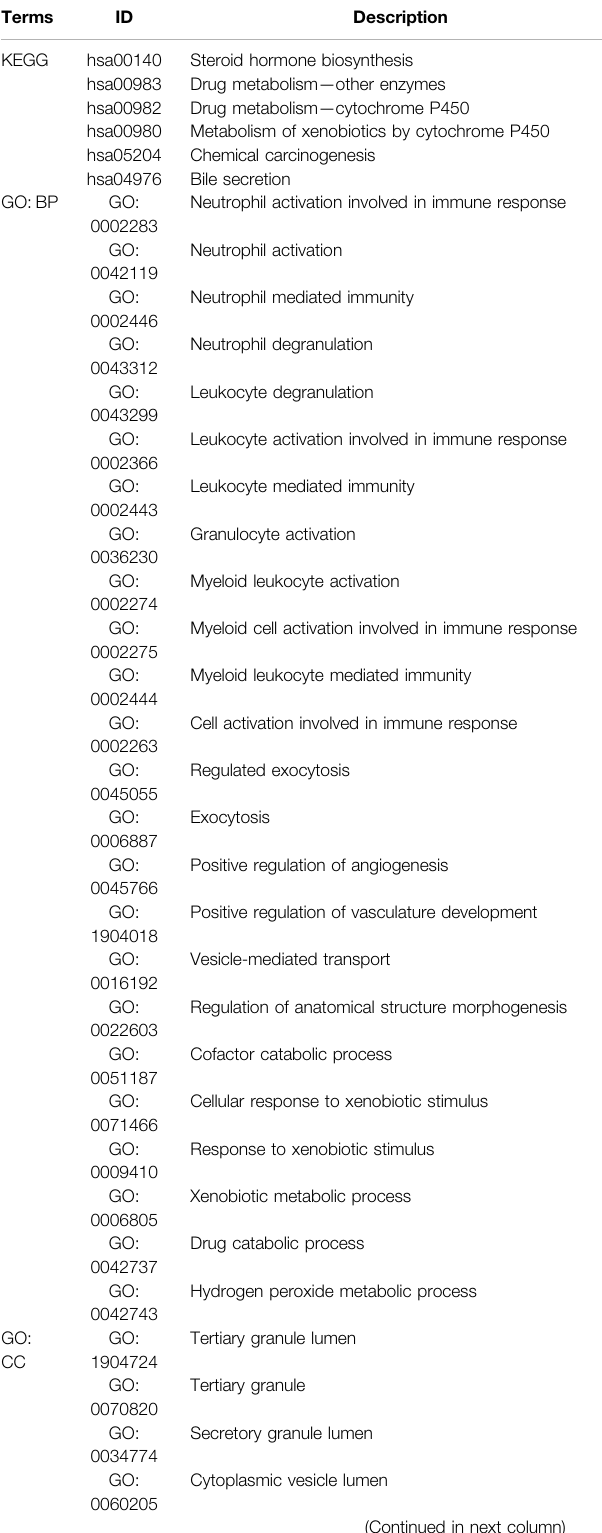
TABLE 2 | ( Continued ) KEGG pathway enrichment analyses and GO functional annotation